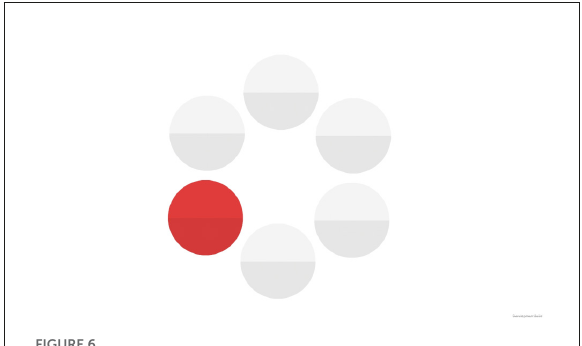
FIGURE6 Screenshot of the circle tapping